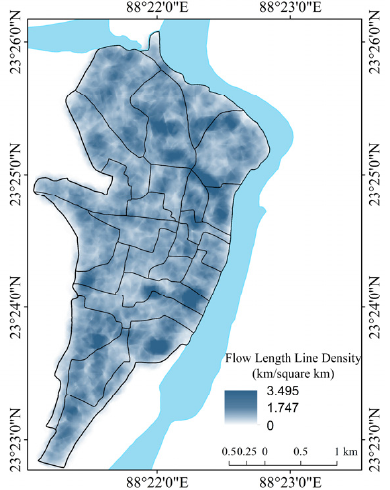
Figure 35. NDVI (2015). Figure 36. NDWI (2015).